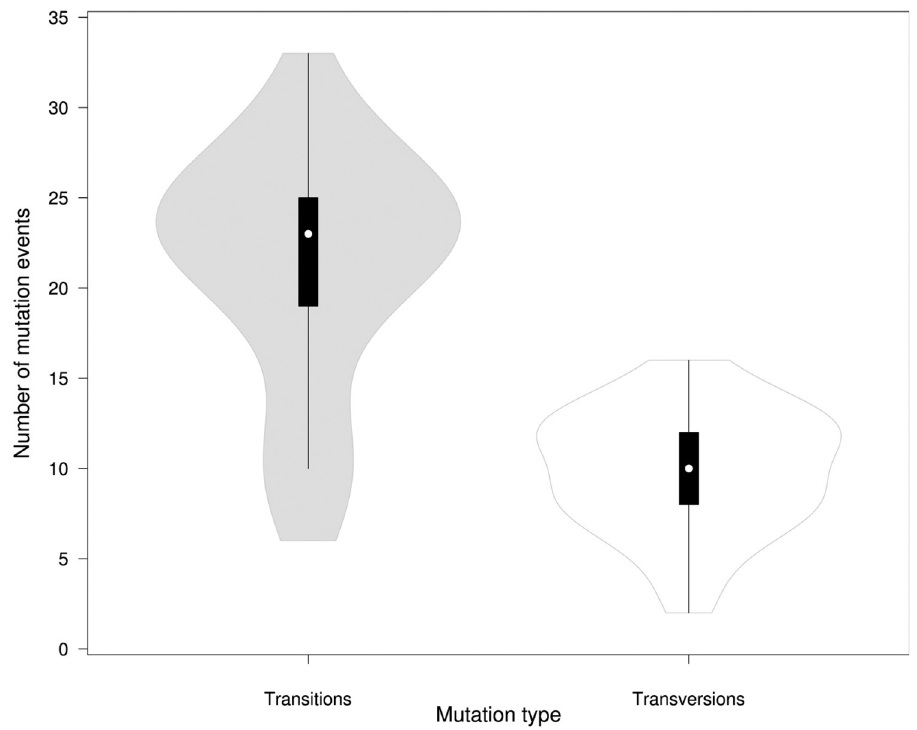
Fig 5. Box plot of distribution of transitions and transversions per genome among the SARS-CoV-2 isolates (n = 39) in Uzbekistan. The cross marks the mean values, the bold line marks median.